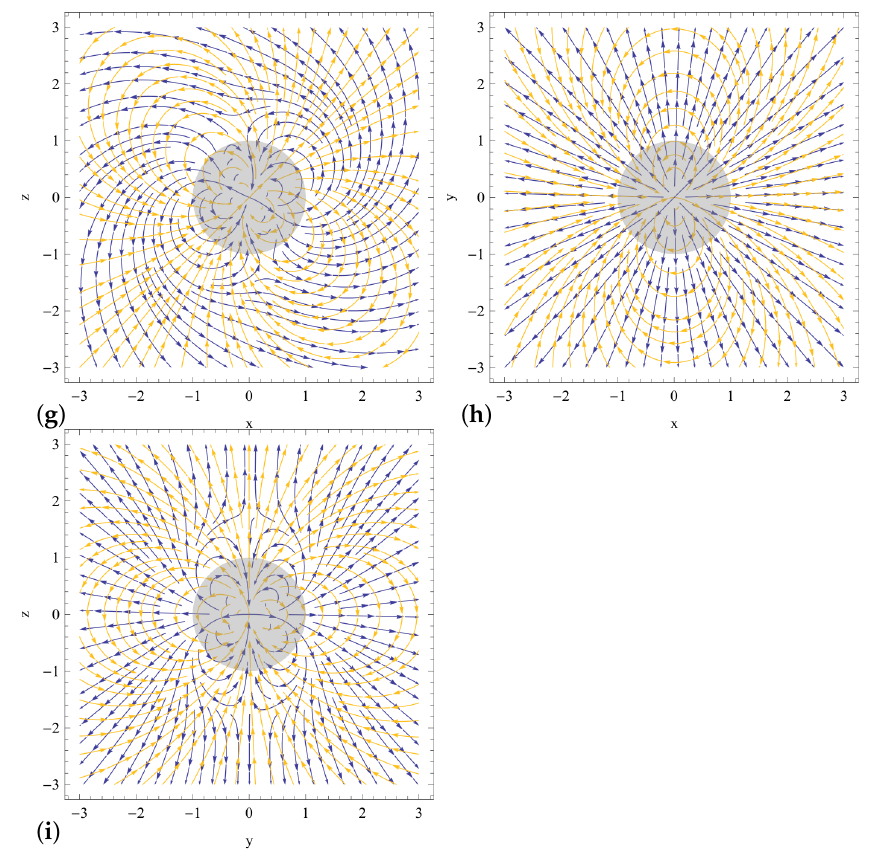
Figure A1. The magnetic (yellow, light in black and white) and electric (blue, dark) field lines projected onto the x − z (panels ( a , d , g )), x − y (panels ( b , e , h )), and y − z (panels ( c , f , i )) planes, for the aligned (panels ( a – c ), the rotation axis is in the z direction, and the magnetic axis is in the x − z plane for the moment plotted), orthogonal (panels ( d – f )) and moderately oblique ( α = π /4; panels ( g – i )) rotators. The semi-transparent disk represents the stellar surface, and note that the plotting software produces spoke patterns when the field on the plane is